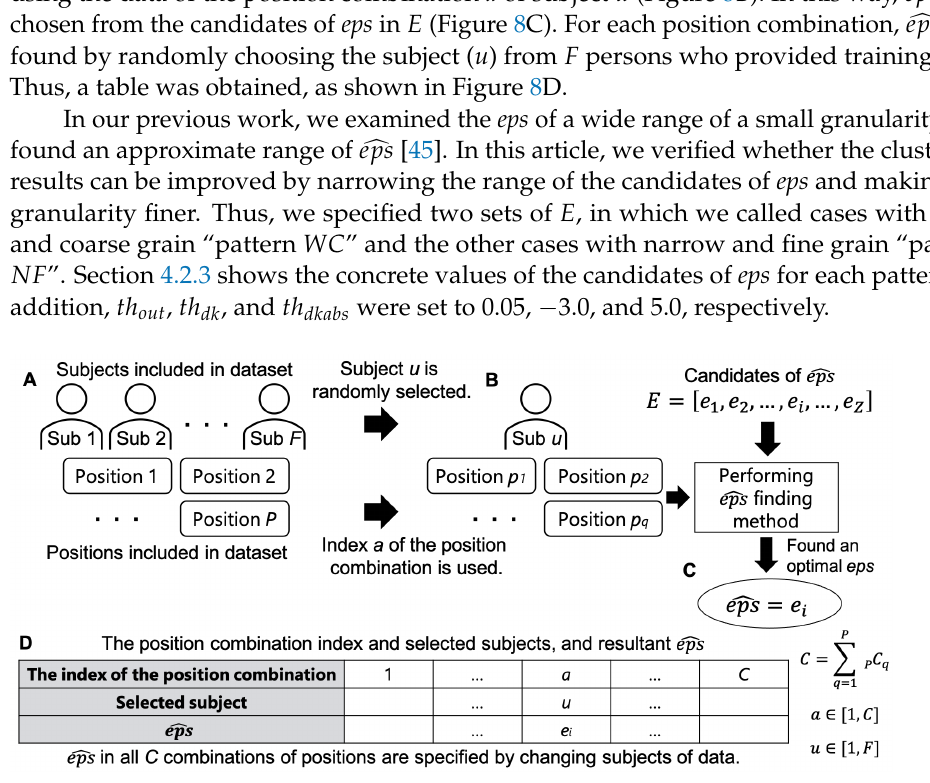
Figure 8. Procedure of the evaluation of finding (cid:99) eps